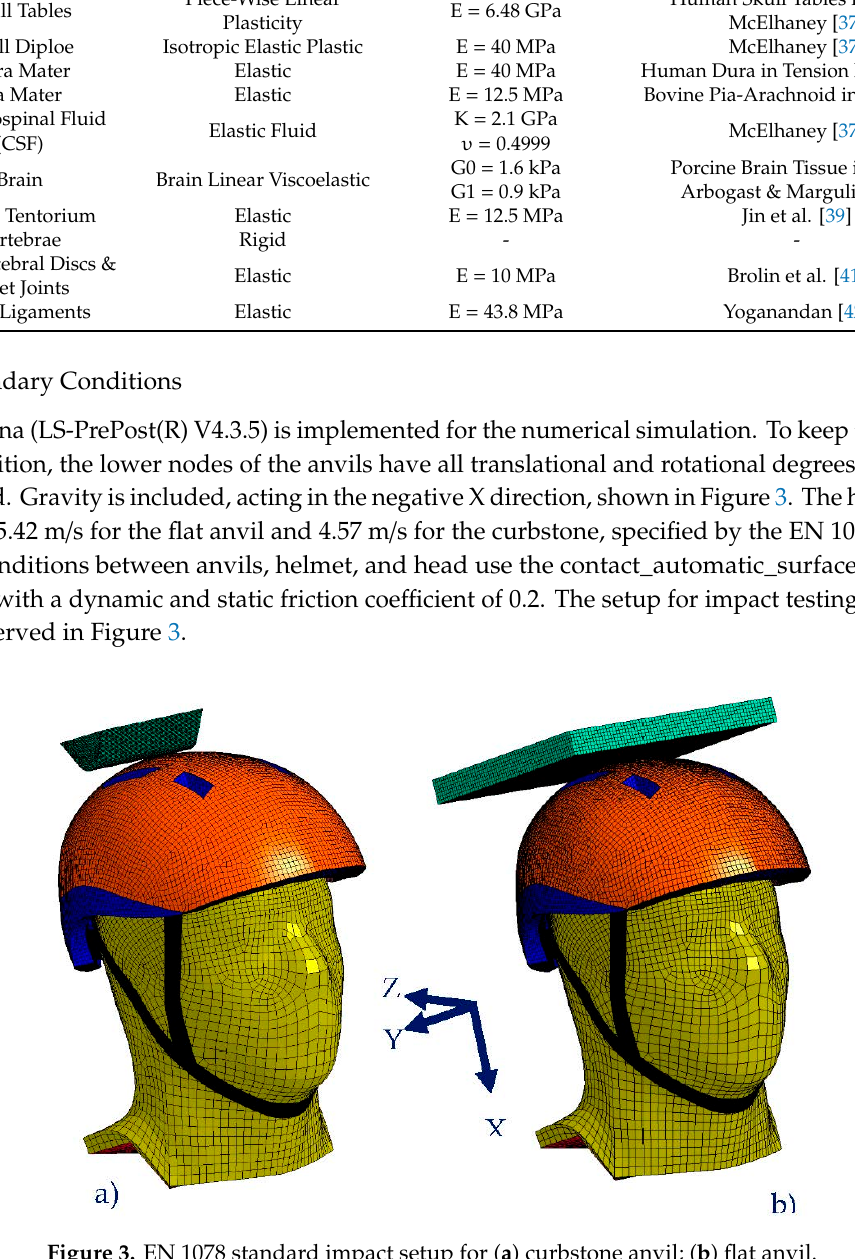
Figure 3. EN 1078 standard impact setup for ( a ) curbstone anvil; ( b ) flat anvil.